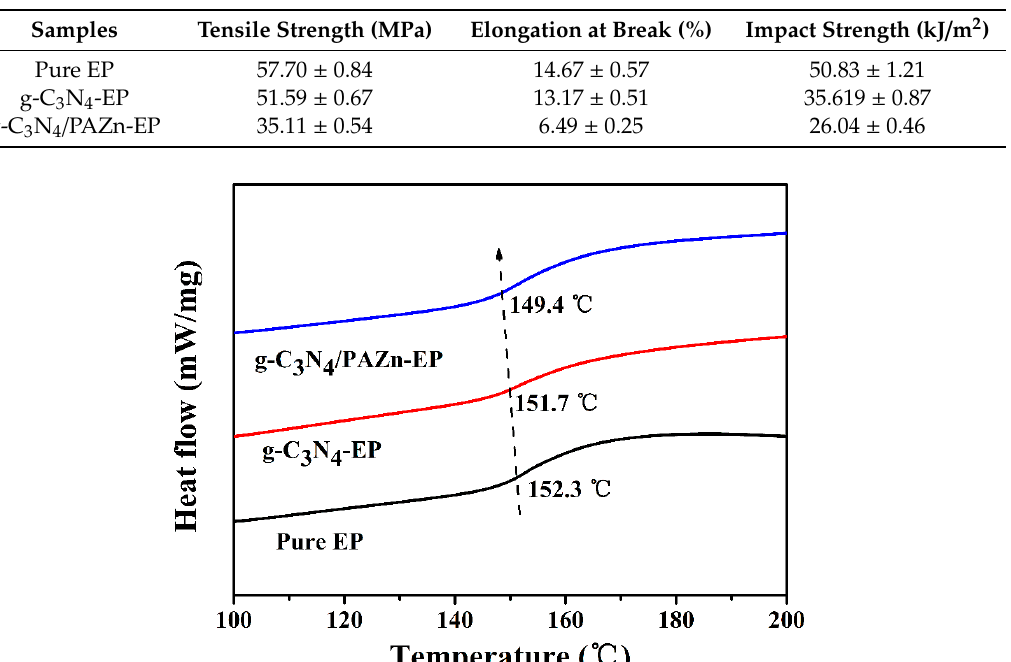
Figure 8. Di ff erential scanning calorimetry (DSC) curves of EP Figure 8. Differential scanning calorimetry (DSC) curves of EP composites.